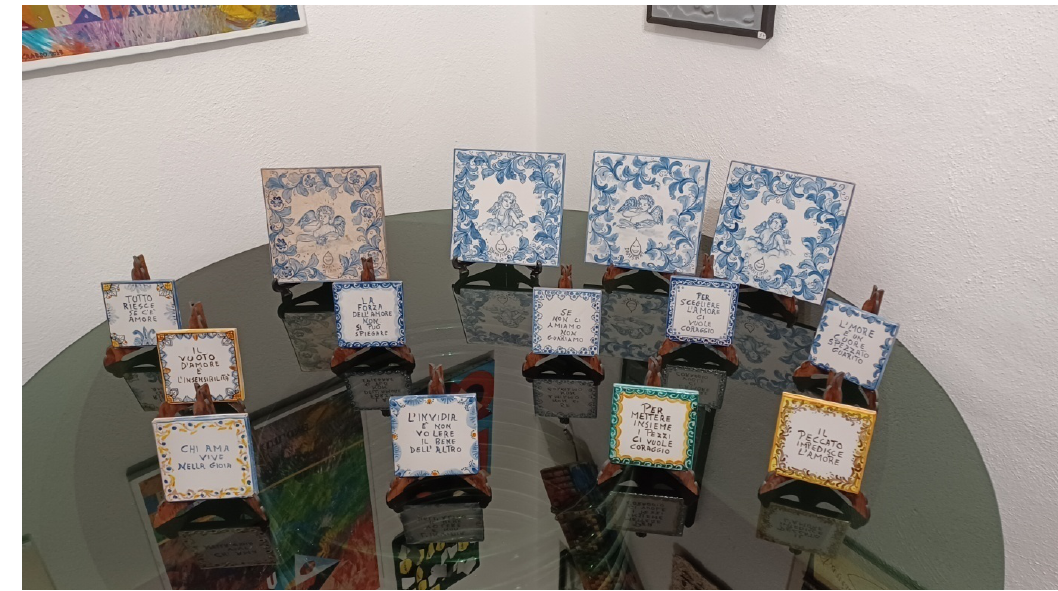
Fig. 6 : 6 December 2022,